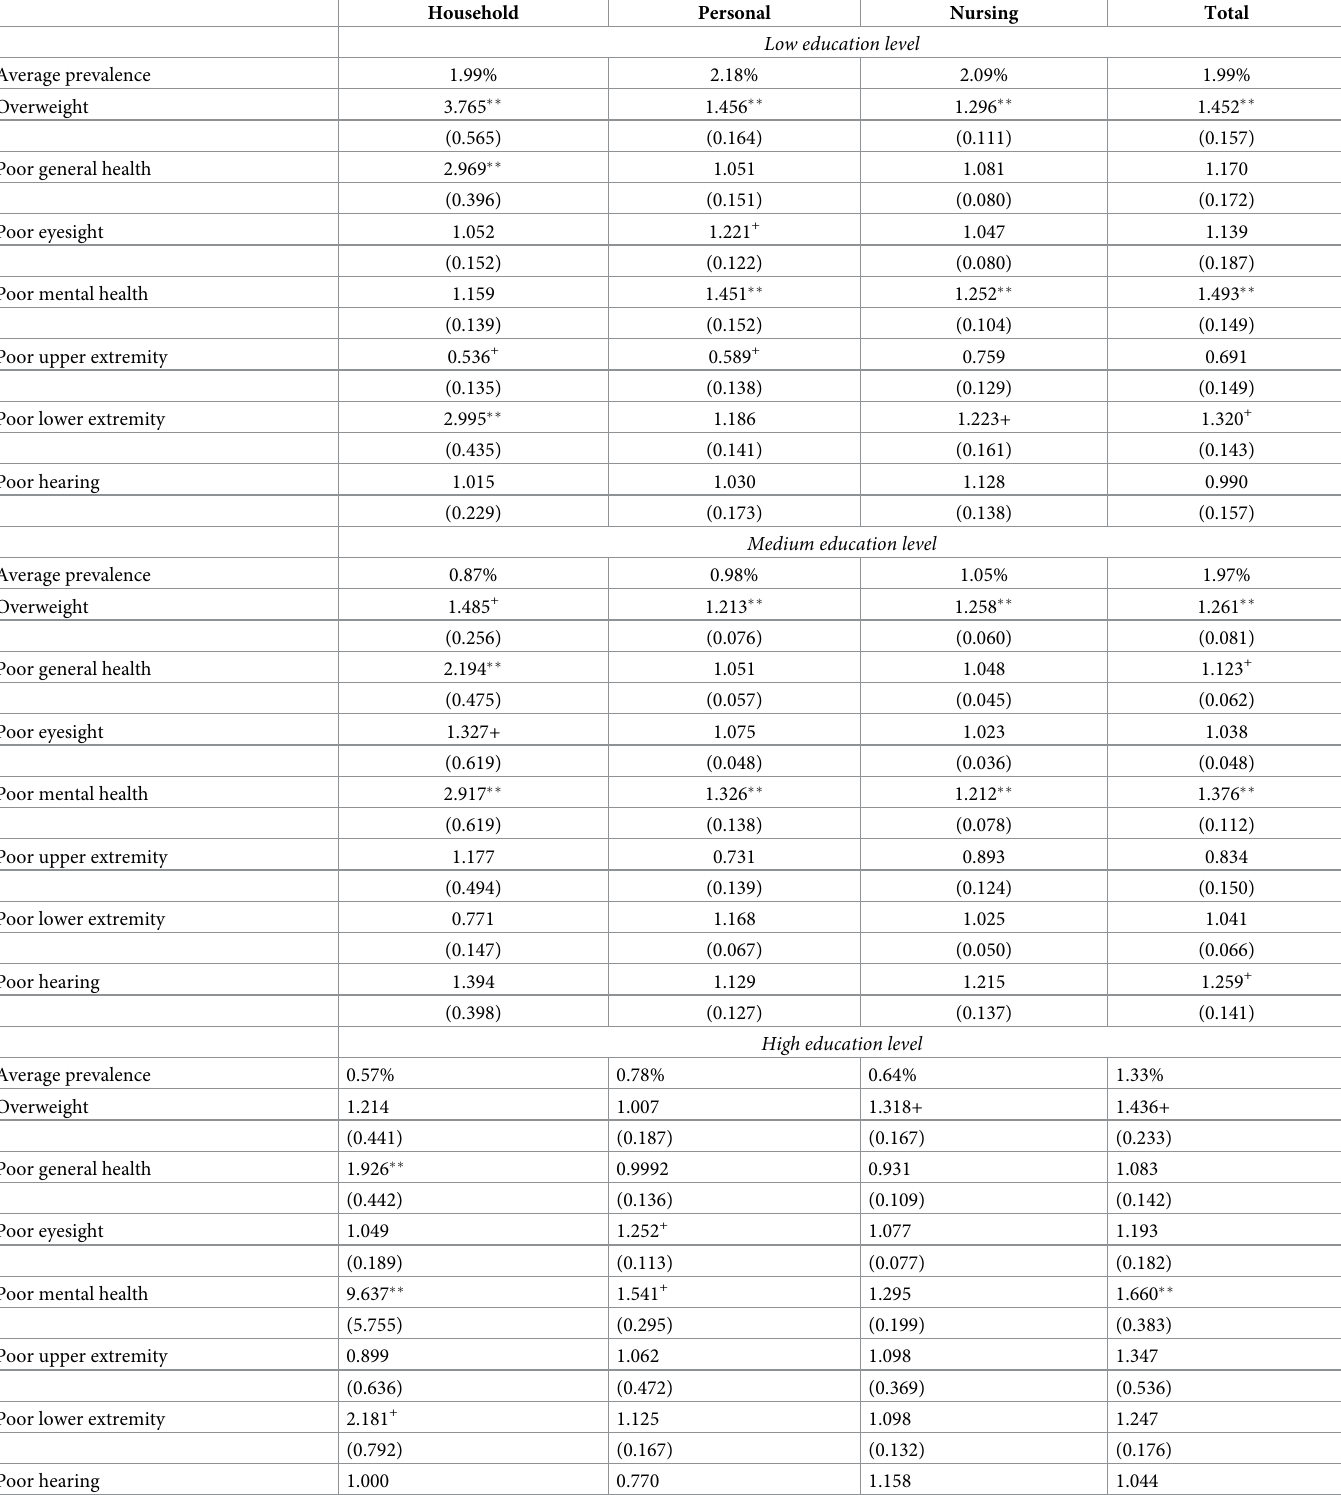
Household Personal Nursing Total Low education level